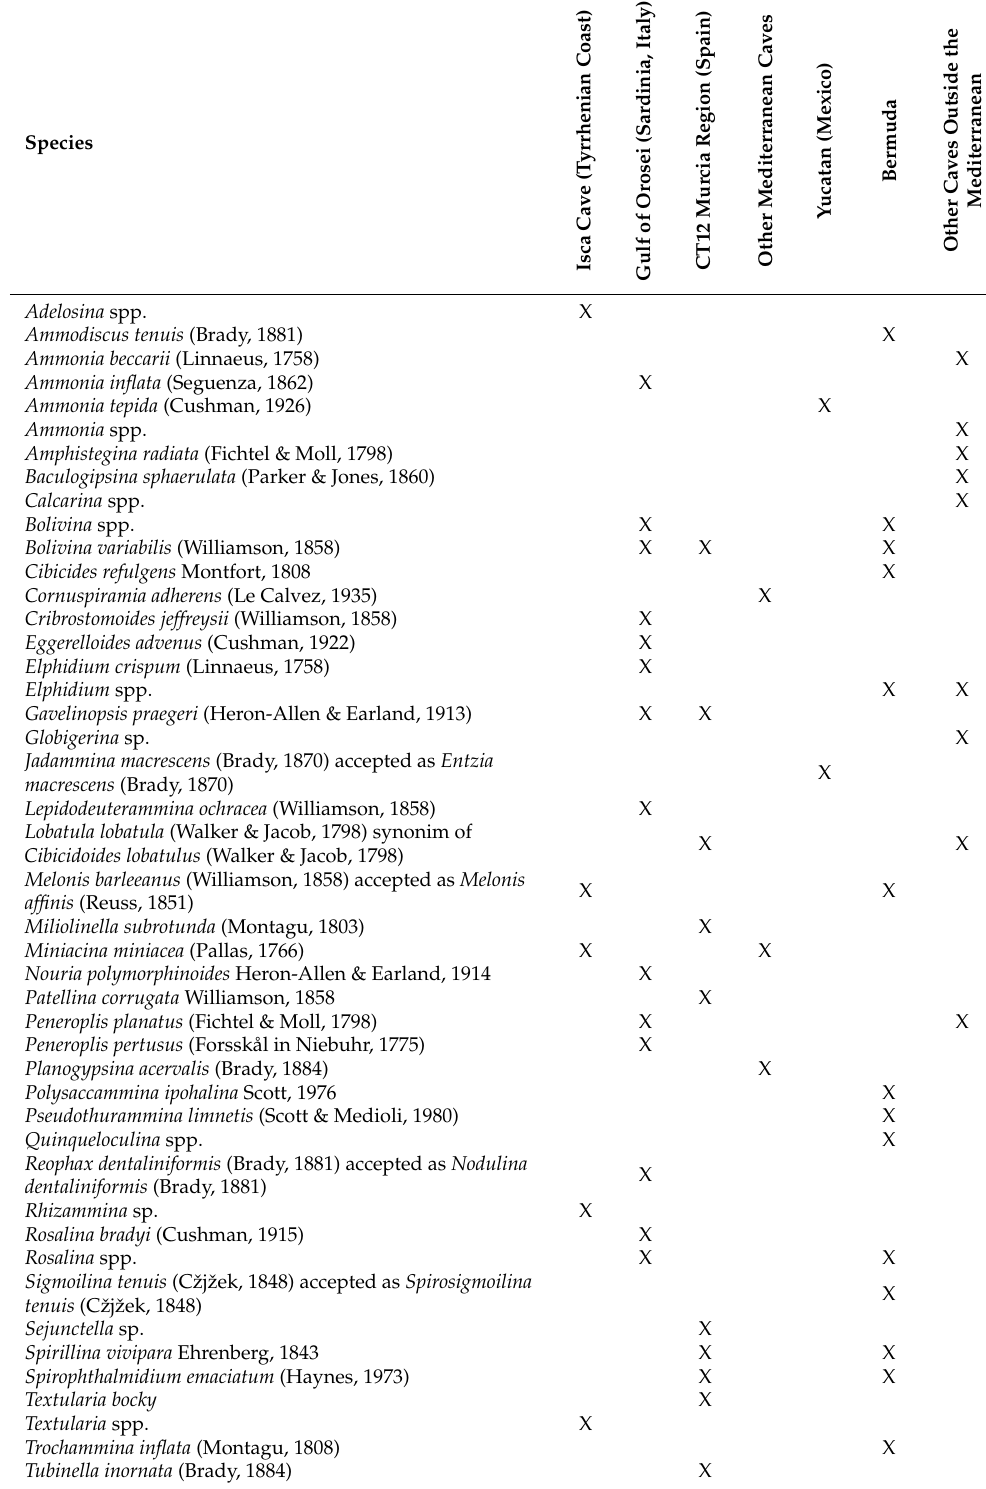
Table 2. List of the main foraminiferal species mentioned in this study, recorded in marine caves and provenance